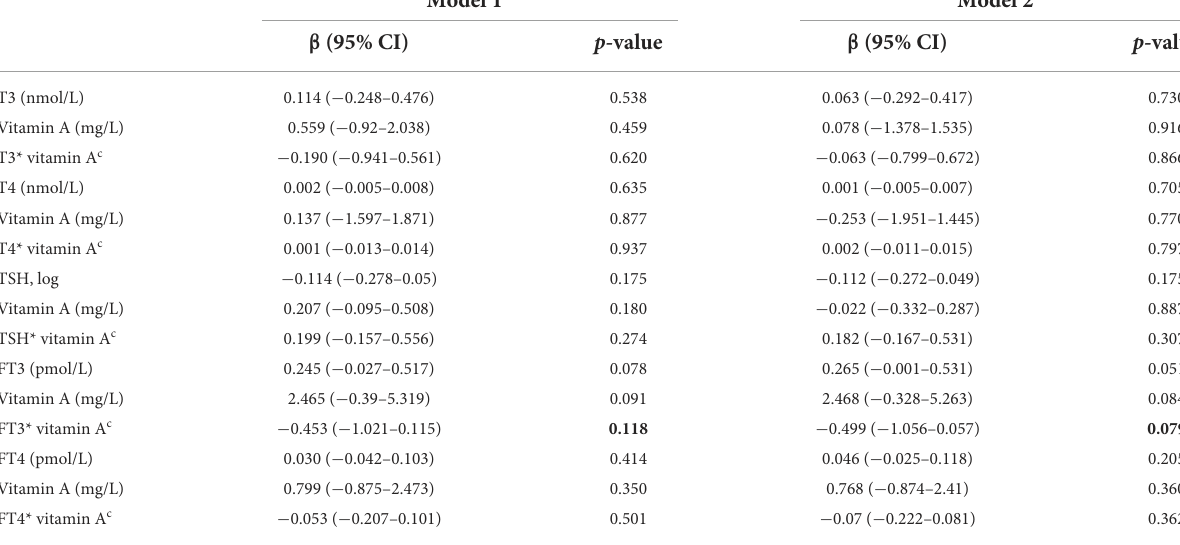
a Model1:Adjustedforgestationalweekatsampling,fetalsex,andgestationalageatbirth(linearandquadratic). b Model2:Adjustedformodel1plusmaternalpre-pregnancyBMI,parity,employed,gestationalweightgain,gestationaldiabetesmellitus. c Thecoefficientoftheinteractionterminregressionmodel.